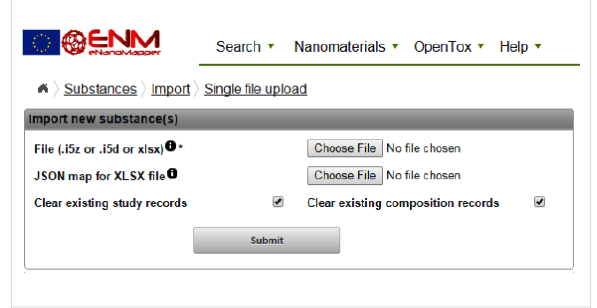
Figure 8: Data upload web page of the database system showing support for two file